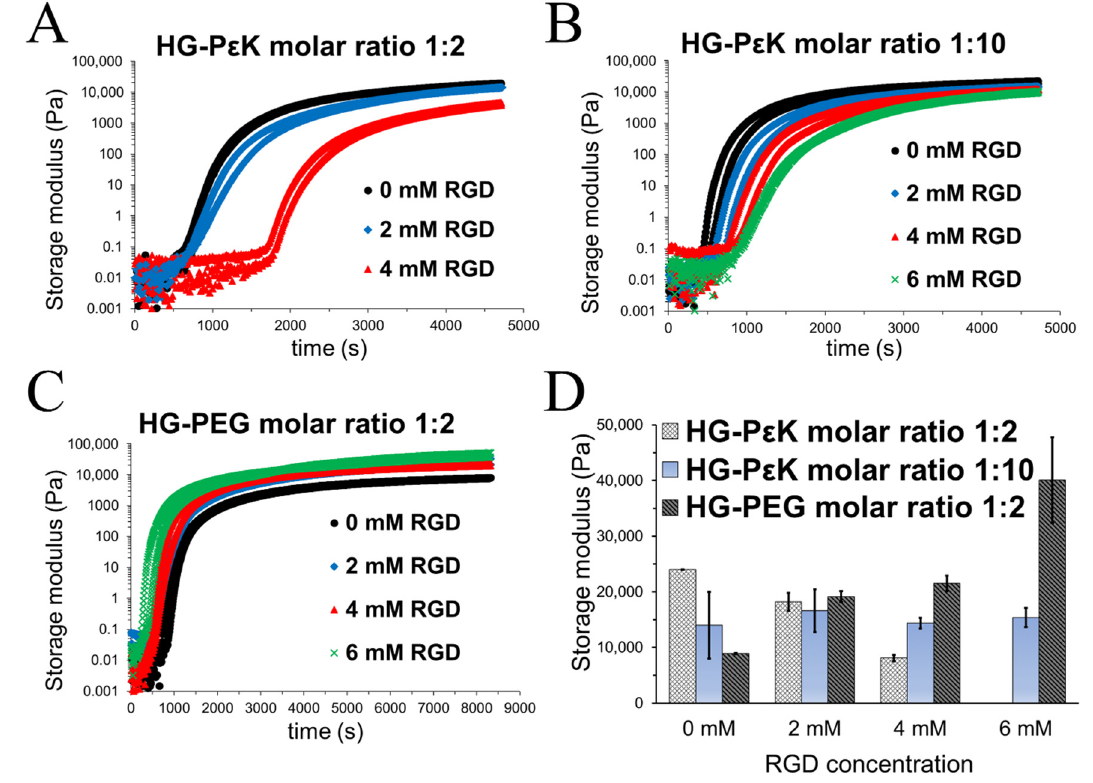
Figure 2. Hydrogel mechanical characterization by oscillatory rheology. Time sweep plots are displayed as two independent flow traces for each hydrogel construct as a function of RGD concentration at 37 ◦ C. ( A ) Time sweep for HG-P ε K molar ratio 1:2 with 0 mM RGD (black circle), 2 mM RGD (blue diamond), and 4 mM RGD (red triangle). ( B ) Time sweep for HG-P ε K molar ratio 1:10 with 0 mM RGD (black circle), 2 mM RGD (blue diamond), 4 mM RGD (red triangle), and 6 mM RGD (green cross). ( C ) Time sweep for HG-PEG molar ratio 1:2 with 0 mM RGD (black circle), 2 mM RGD (blue diamond), 4 mM RGD (red triangle), and 6 mM RGD (green cross). ( D ) Storage moduli as a function of RGD concentration at 37 ◦ C. The storage moduli were obtained at 1 Hz from frequency sweeps in the linear viscoelastic region presented in Figures S8–S10 in the Supplementary Materials. Data represent mean ± standard deviation (n = 2).